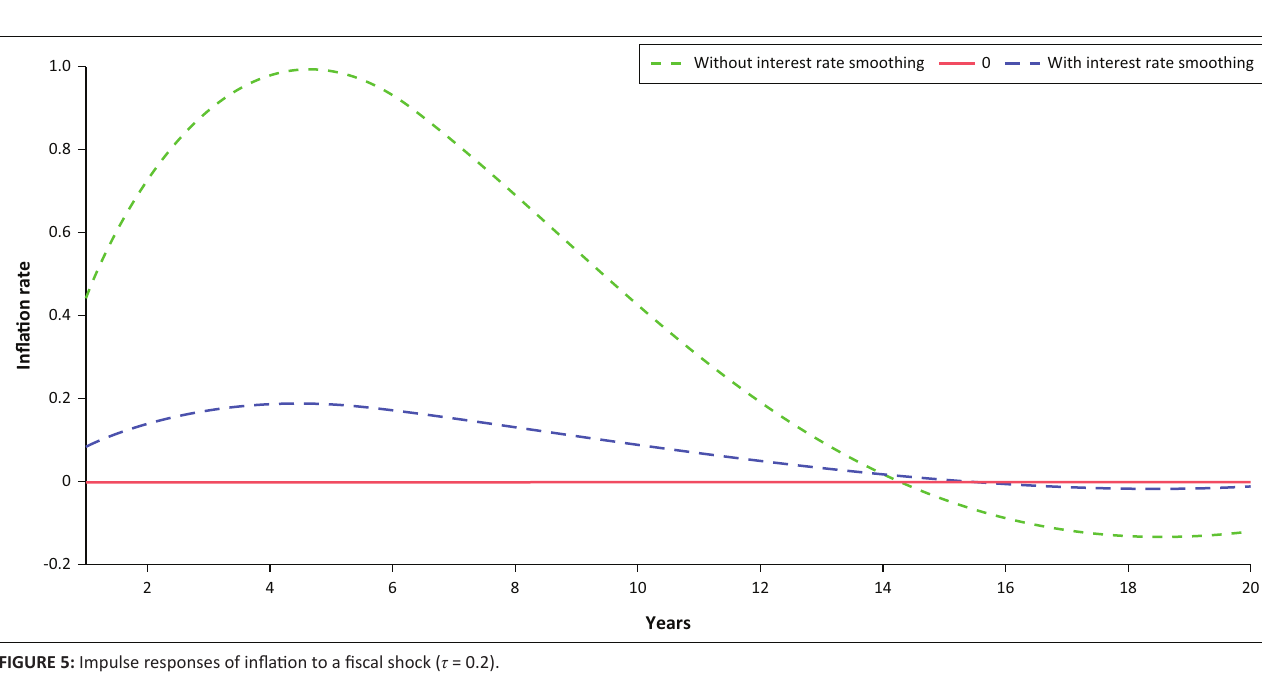
FIG URE 4: Impulse responses of inflation to a monetary tightening shock ( τ = 0.2).